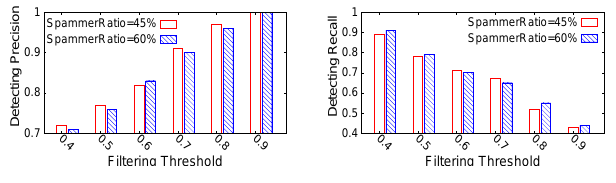
Figure 7. Effects of Spammer Ratio on